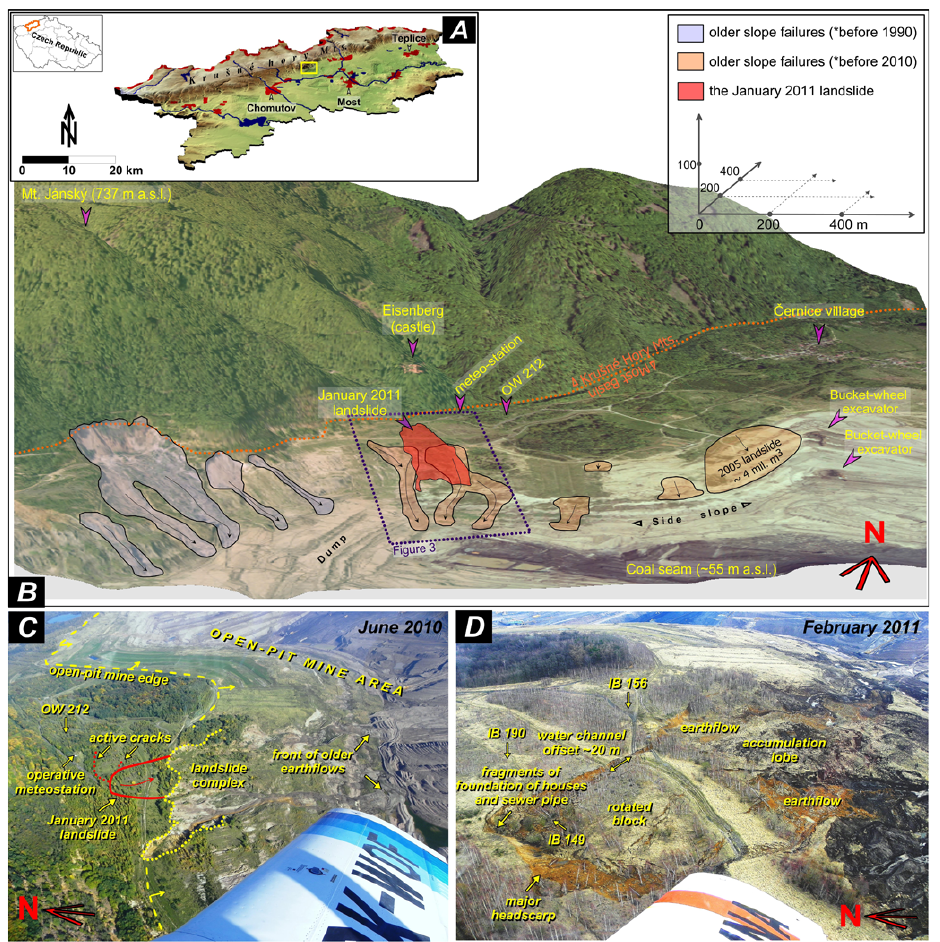
Fig. 1. (A) , location of the study site; (B) , three-dimensional view from SE towards structural slope of the Kruˇsn´e hory Mountains. and anthropogenic relief of the Most Basin. From the 1980s until present, several slope deformations occurred within the side slope of near open- cast mine (landslide situation, modified from Burda et al., 2011; DEM: Zabaged 2006); (C) , an aerial overview of the landslide complex situated at the edge of the open-cast mine – the position of the landslide during January 2011 is marked by the red line, while the positions of the meteostation, observation well, and main morphological features are marked by the yellow line and arrows (foto: J. Burda, June 2009); (D) , a detailed aerial view on the January 2011 landslide – the position of inclinometric boreholes is marked as well as significant morphological features (foto: J. Burda, February